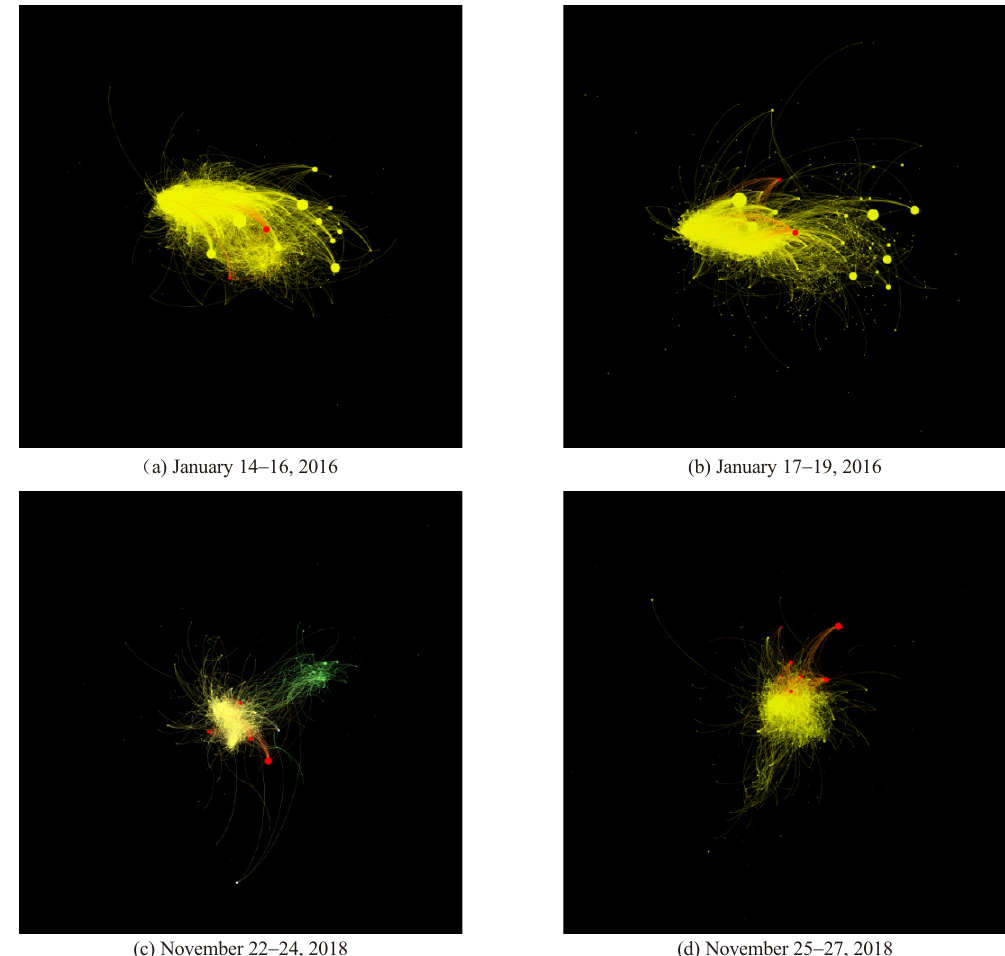
Fig. 2 Plots of the social network analysis. There is a clear pattern change between networks of 2016 (Figs. 2a and 2b) and networks of 2018 (Figs. 2c and 2d). Nodes with less than 1 degree are masked from the whole network to better reveal the whole